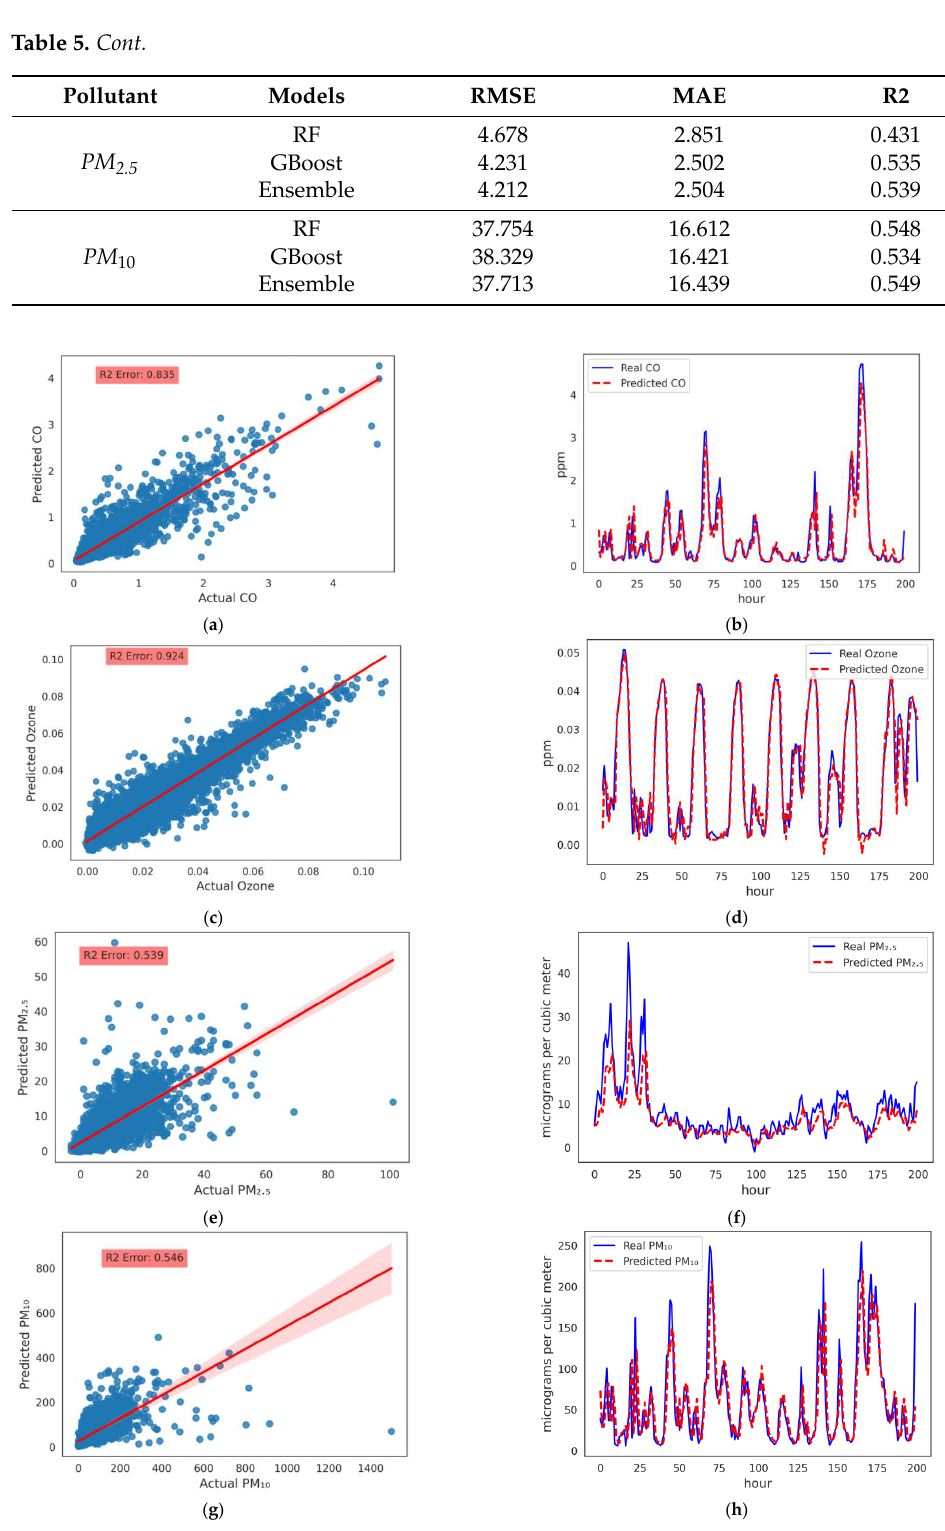
Figure 5. Proposed models for CO, 𝑂 3 , 𝑃𝑀 2.5 and 𝑃𝑀 10 results: ( a ) Actual and predicted data using LSTM model for CO ; ( b ) Line chart for predicted and actual CO values; ( c ) Actual and predicted data using LSTM model for 𝑂 3 ; ( d ) Line chart for predicted and actual 𝑂 3 values; ( e ) Actual and predicted data using ensemble model for 𝑃𝑀 2.5 ; ( f ) Line chart for predicted and actual 𝑃𝑀 2.5 values; ( g ) Actual and predicted data using ensemble model for 𝑃𝑀 10 ; ( h ) Line chart for predicted and actual 𝑃𝑀 10 values (created by author).